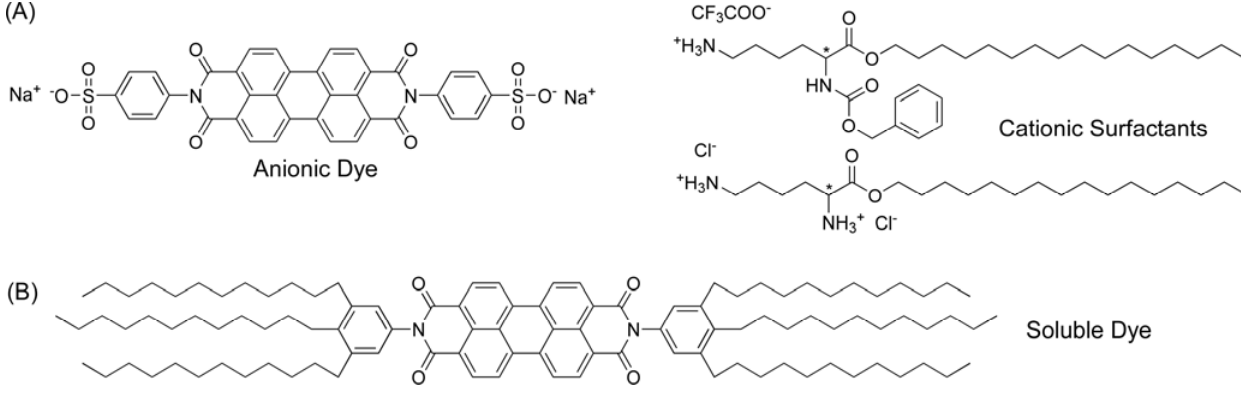
Figure 2. (A) Charged perylene bisimide and surfactants. (B) Perylene bisimide with alkyl